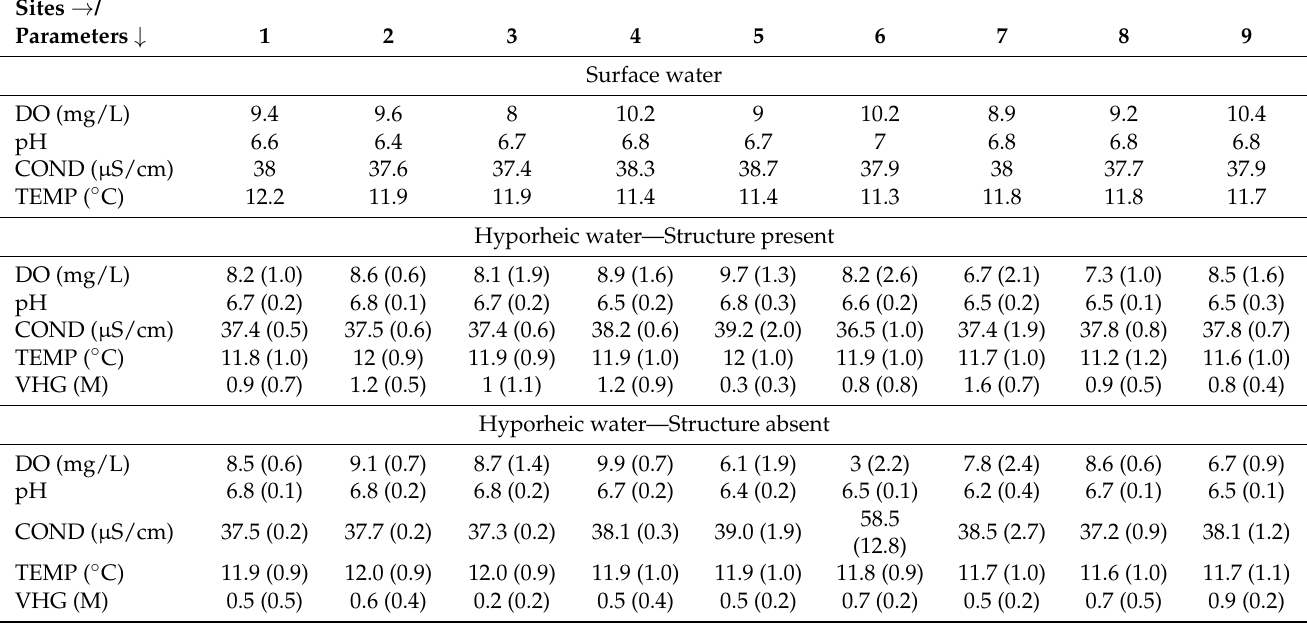
Table 5. Mean physical and chemical parameters associated with sites 1–9 on the lower Mokelumne River. Abbreviations are as follows: DO = dissolved oxygen; COND = conductivity; TEMP = average daily temperature; VHG (M) = vertical hydraulic gradient (magnitude). Standard deviations are in